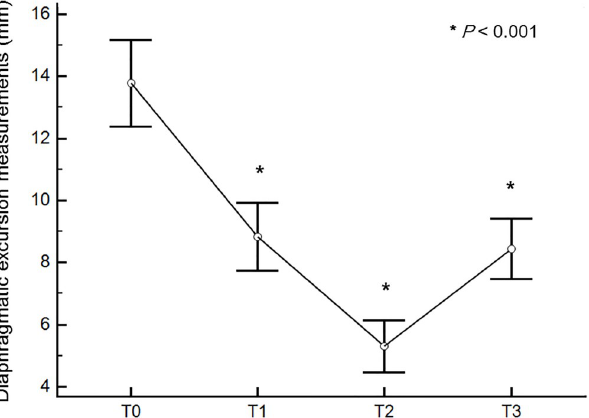
Fig 3. Diaphragmatic excursions at each surgical time point. Diaphragmatic movement was decreased gradually during operation. Diaphragmatic excursion had the largest drop 90 minutes after Trendelenburg position with pneumoperitoneum (T2) compared to after sedation (T0, P < 0.001). T0 = after sedation (bispectral index < 60, train- of-four (TOF) ratio > 0.9); T1 = after the intubation (bispectral index < 60, TOF ratio = 0); T2 = 90 minutes after Trendelenburg position with pneumoperitoneum; T3 = after operation with recovery of muscle relaxation under mechanical ventilation (bispectral index < 60, TOF ratio > 0.9).